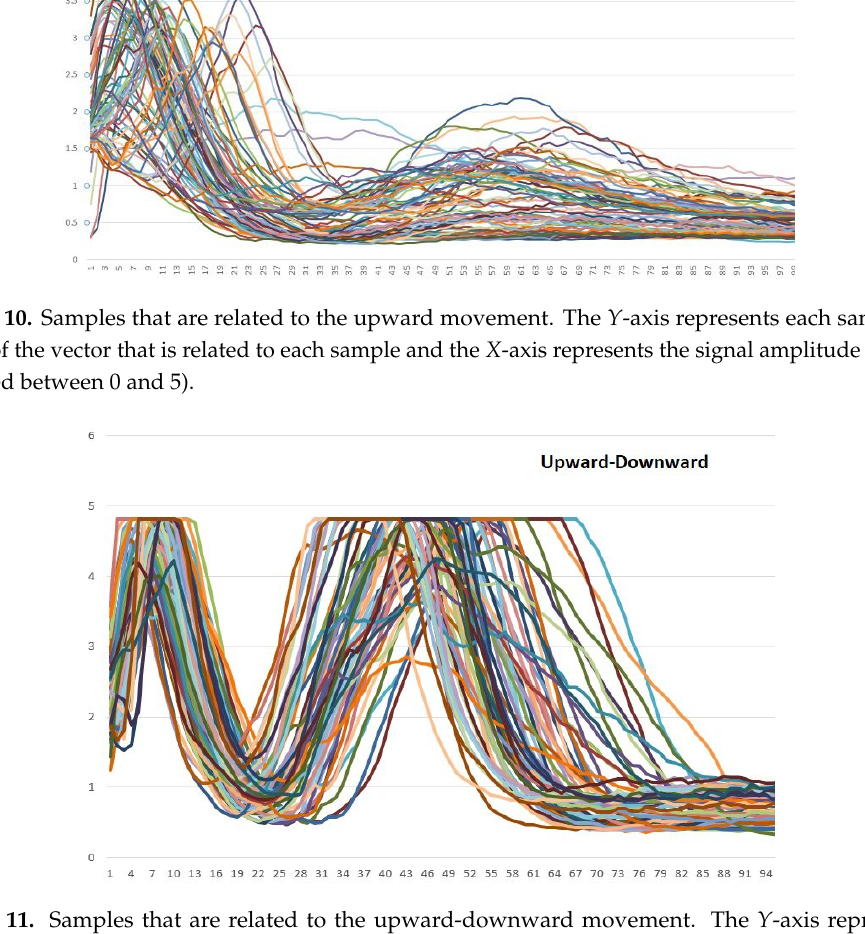
Figure 11. Samples that are related to the upward-downward movement. The Y -axis represents each sampling point of the vector that is related to each sample and the X -axis represents the signal amplitude (it was mapped between 0 and 5).